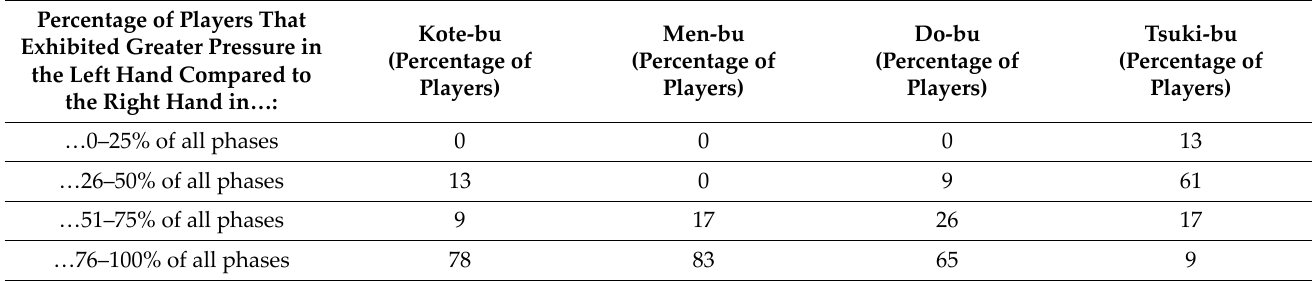
Table 3. Player‑dependent percentages of pressure distribution across attack phases (five in Kote‑bu, Men‑bu, and Do‑bu; two in Tsuki‑bu).